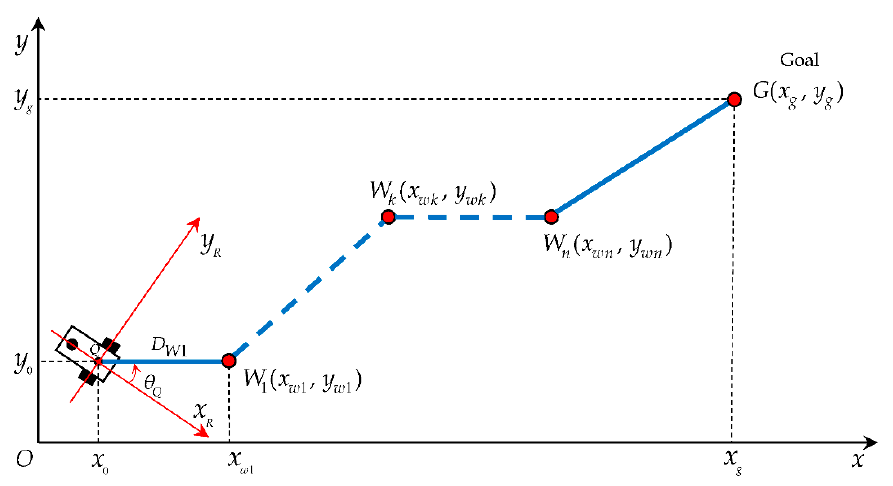
Figure 1. The differential drive wheeled mobile robot tracks the optimal path with several waypoints.